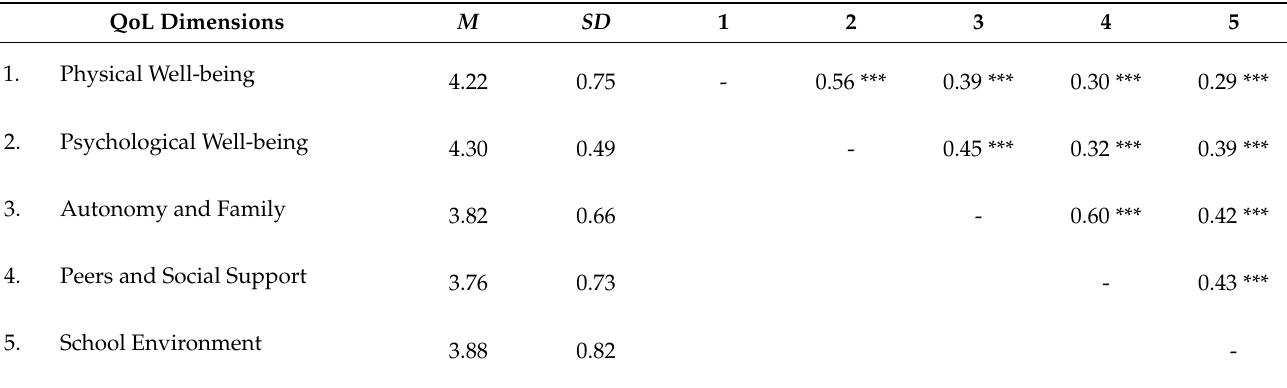
Table 3. Descriptive and correlation matrix of QoL dimensions ( n = 363).